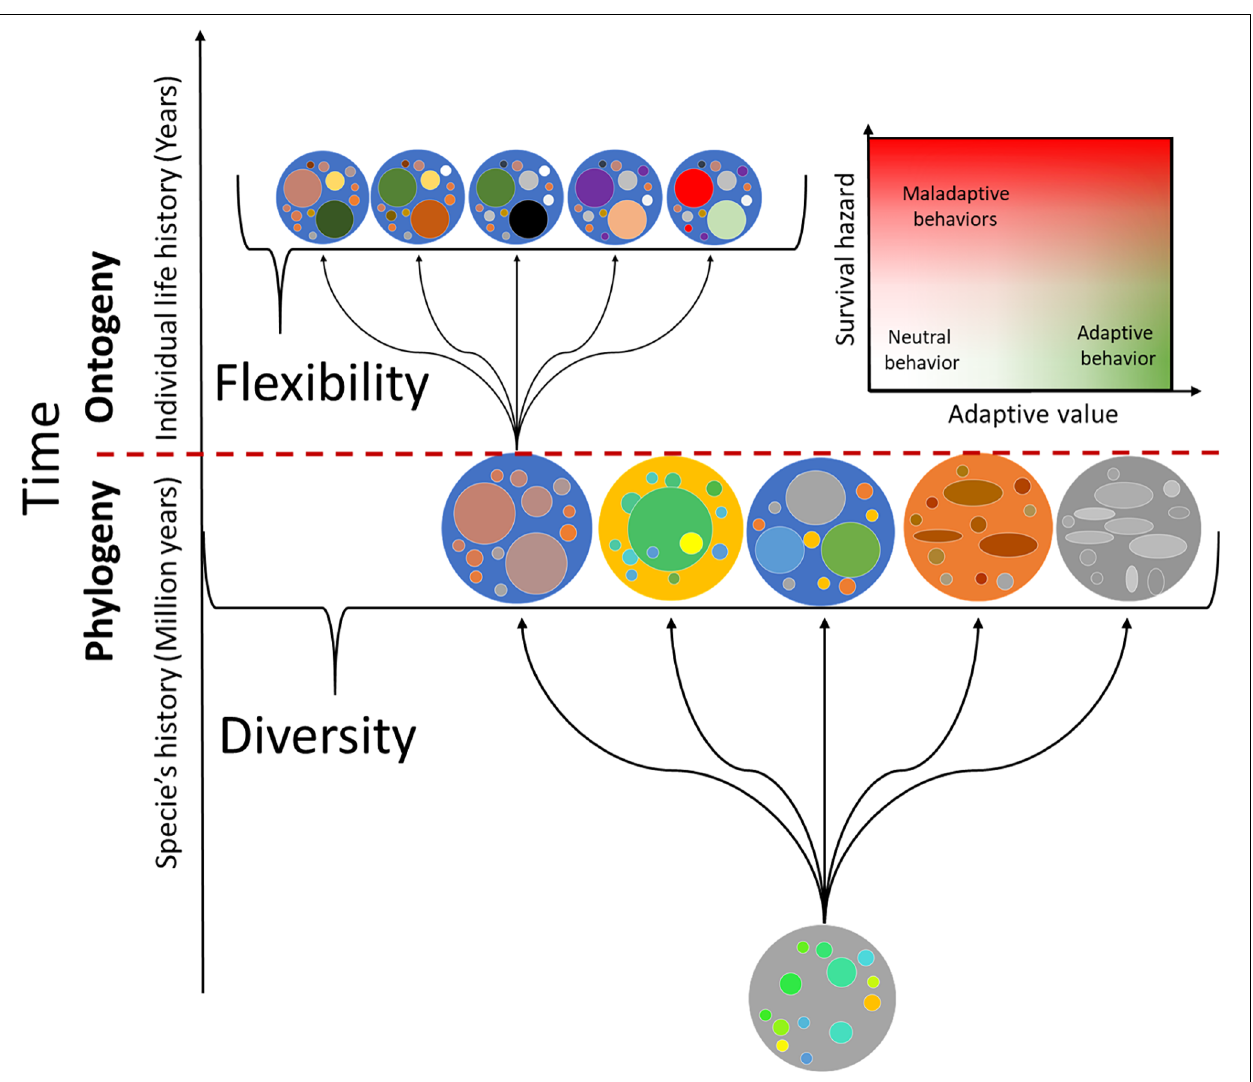
FIGURE 3 | Schematic of the historic progression of organism coupling with their environment leading to a diversity of organisms (phylogenetic mechanisms) and behavioral flexibility (ontogenetic mechanisms). Evolution may generate important changes in organism morphology, producing major differences between different species (depicted with different shapes and colors). Ontogenetic mechanisms will be constrained by phylogenetic history but will produce a large number of potential behaviors from which only a subsample will appear. The behaviors that appear during ontogeny will depend on the individual life history of each organism that will lead iteratively to different functional structures (depicted as change in color but not shape), which will ultimately produce different behaviors and functional